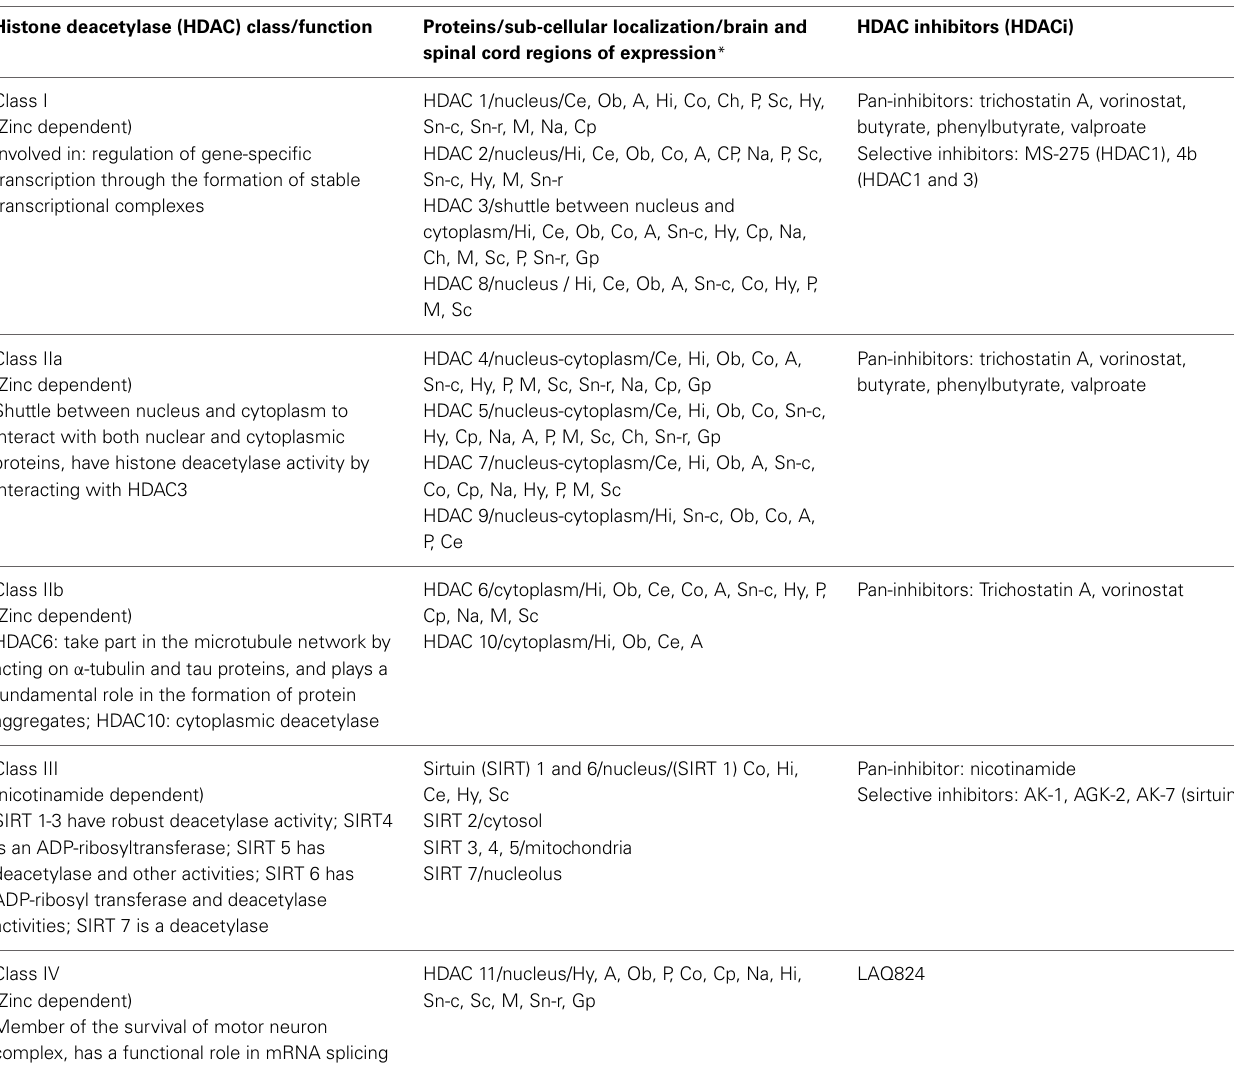
Table 1 | Mammalian histone deacetylase (HDAC) proteins and some of their inhibitors (HDACi). Histone deacetylase (HDAC) class/function Proteins/sub-cellular localization/brain and spinal cord regions of expression